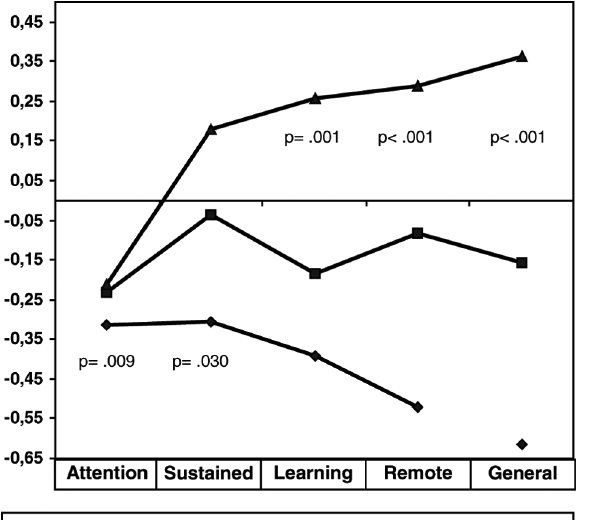
Figure 2. Domain z-scores according to educational attainment (>7 and ≤ 7 years).